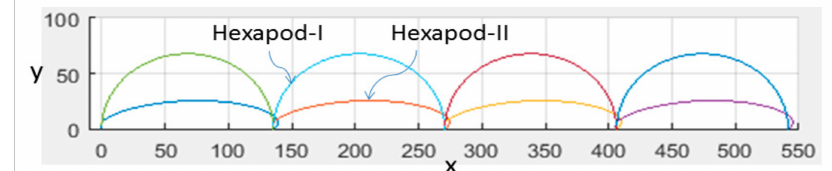
Figure 18. Loci of center of gravity: Hexapod-I versus